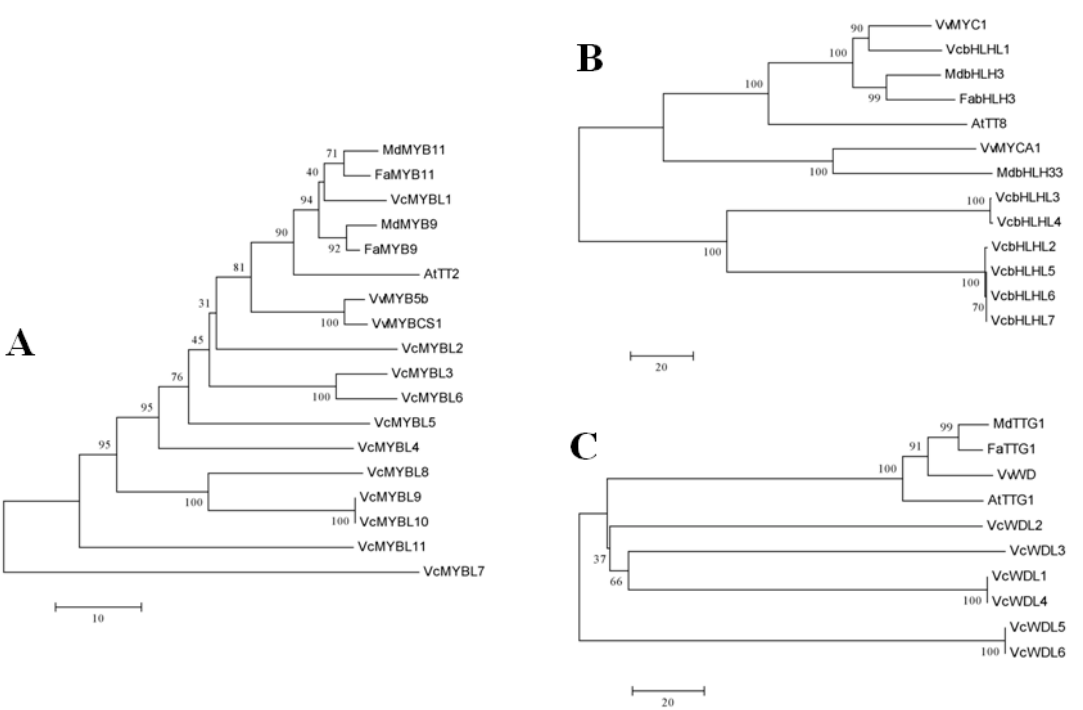
Figure 1: Phylogenetic trees of the MYB-bHLH-WD40 complex gene family members in blueberry fruits. ( a ) fruits. ( a ) Phylogenetic tree of transcription factor / MYB families, ( b ) phylogenetic tree of transcription Phylogenetic tree of transcription factor/MYB families, ( b ) phylogenetic tree of transcription factor/basic factor / basic helix-loop-helix (bHLH) families, ( c ) phylogenetic tree of domain protein / WD-repeat helix-loop-helix (bHLH) families, ( c ) phylogenetic tree of domain protein/WD-repeat (WD40) families. (WD40)